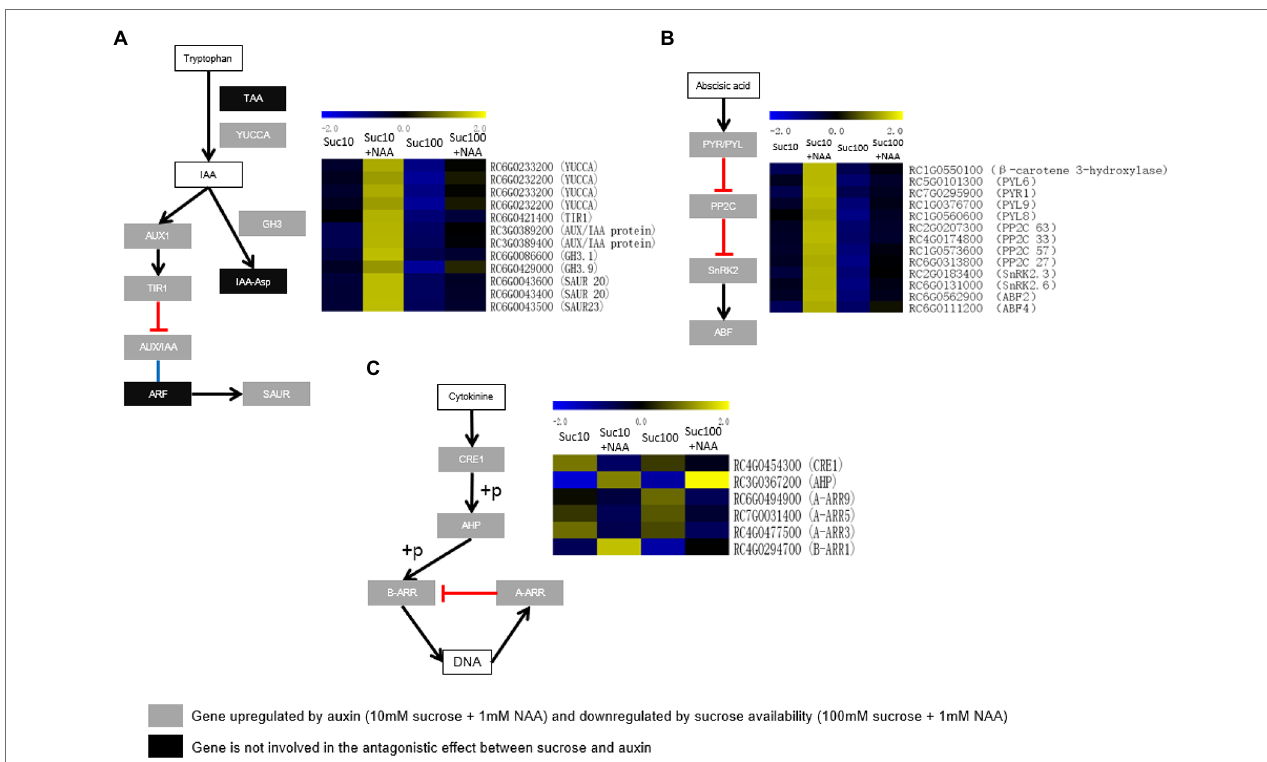
FIGURE 8 | Expression patterns of (A) the genes related to auxin biosynthesis ( TAA and YUCCA ), conjugation to amino acid ( GH3 ), transport ( AUX1 ), and signaling ( TIR1 , AUX/IAA , ARF , and SAUR ); (B) the genes related to abscisic acid signaling ( PYR/PYL , PP2C , SnRK2, and ABF ), and (C) the genes related to cytokinin signaling ( CRE1 , AHP , A-RR, and B-RR ) in response the combined effect of auxin and sucrose in buds. S10, 10 mM sucrose; S10N, 10 mM sucrose + 1 μ M NAA; S100, 100 mM sucrose; and S100N, 100 mM sucrose + 1 μ M NAA. Dark green labels, enzymes-encoding genes repressed by auxin but stimulated by sucrose. Gray labels, enzymes-encoding genes repressed by sucrose but stimulated by auxin. Heatmap color (blue to yellow), gene transcription level (low to high,